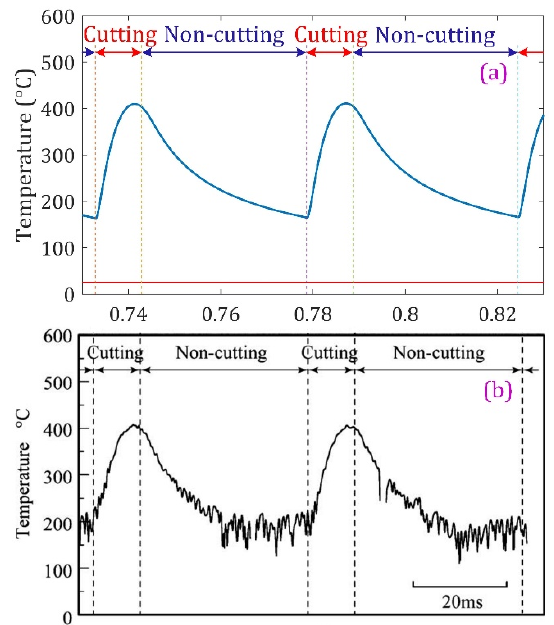
Figure 9. Temperature history at ( x , y , z ) = (0.1, 0.6, 1.3): ( a ) the simulation, and ( b ) the experiment, presented by Sato et al. [35].